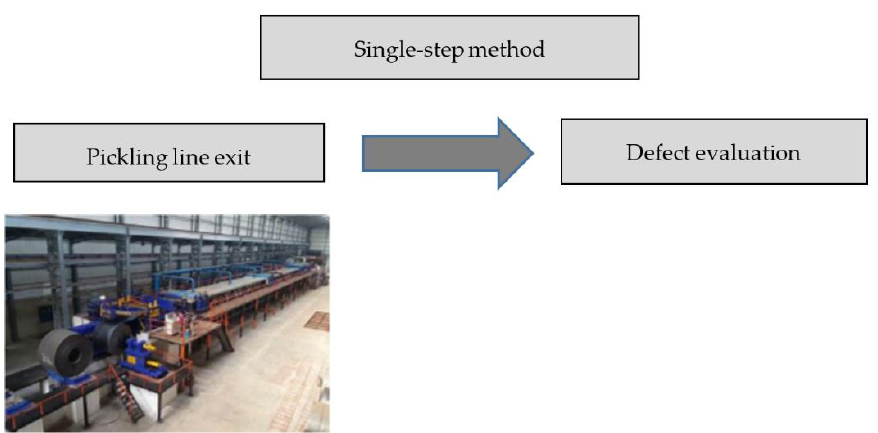
Figure 10. The single-step defect evaluation method chart.